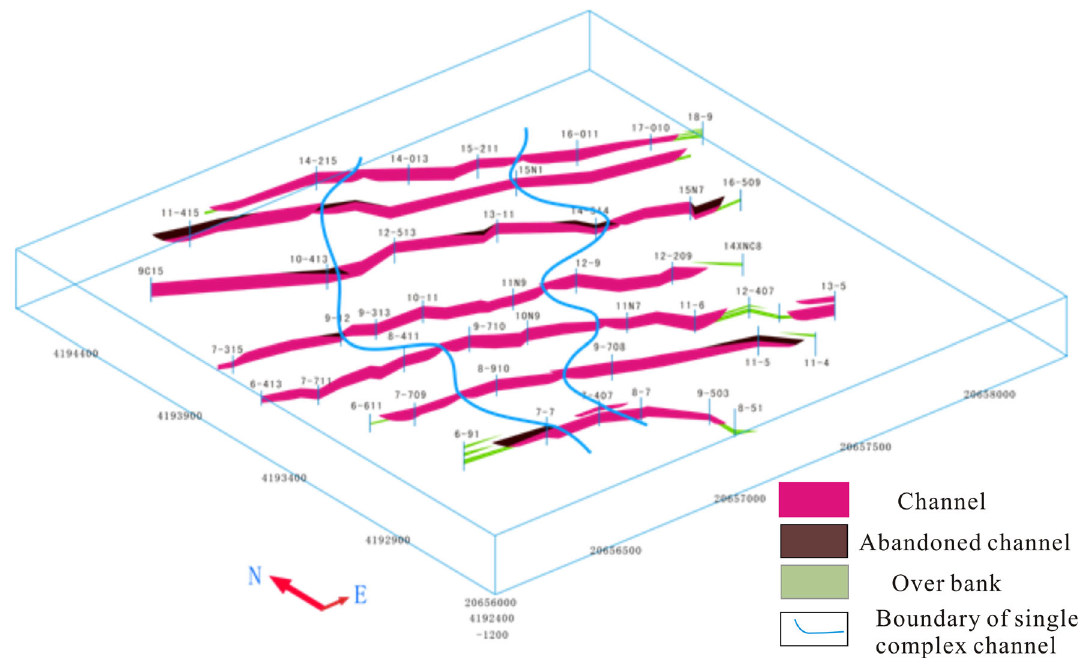
Fig. 5 Division results of single channel belt in Ng33 thin layer according to the four division signs found in the